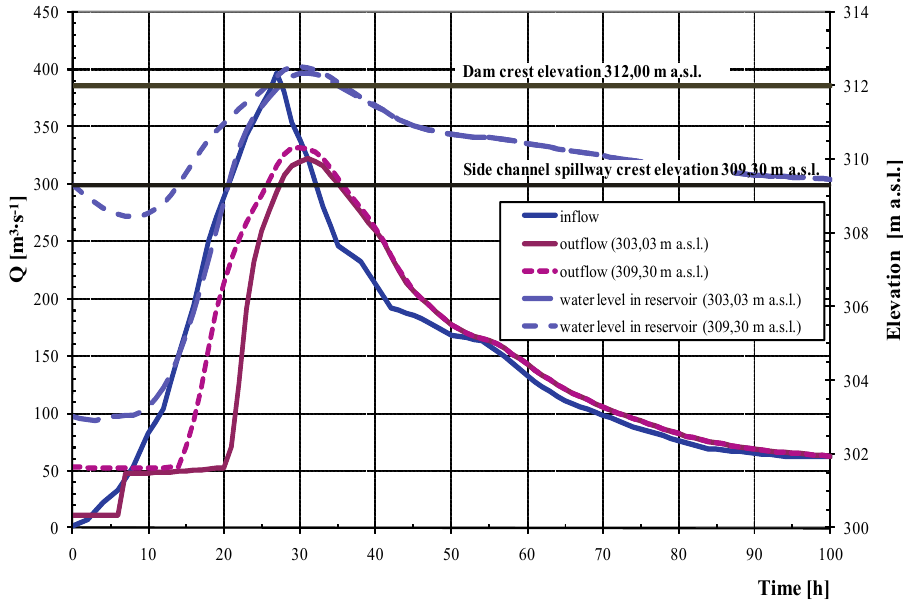
Fig. 4. Transformation of flood wave Q 0.5% for the existing reservoir outlet devices (corrected spillway capacity ability), for initial state of water levels in the reservoir at 303.03 and 309.30 m